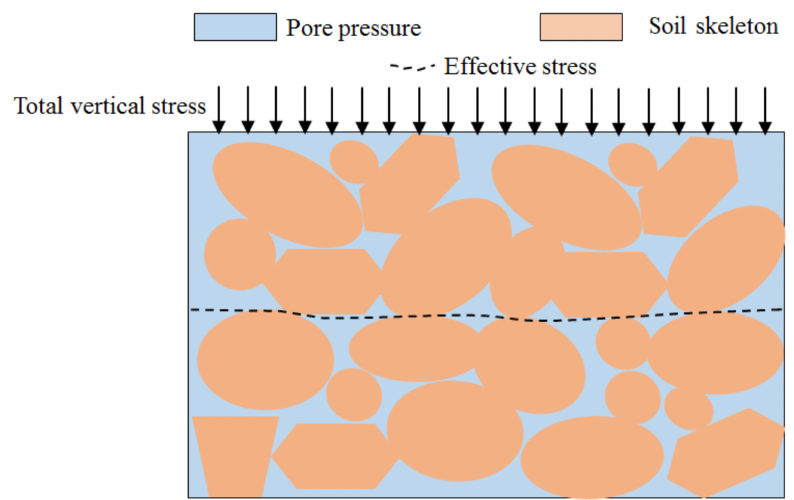
Figure 2. Principle of e ff ective stress with saturated soil (reproduced with permission from Wesley, L. D, Principle of E ff ective Stress published by John Wiley & Sons [16]).